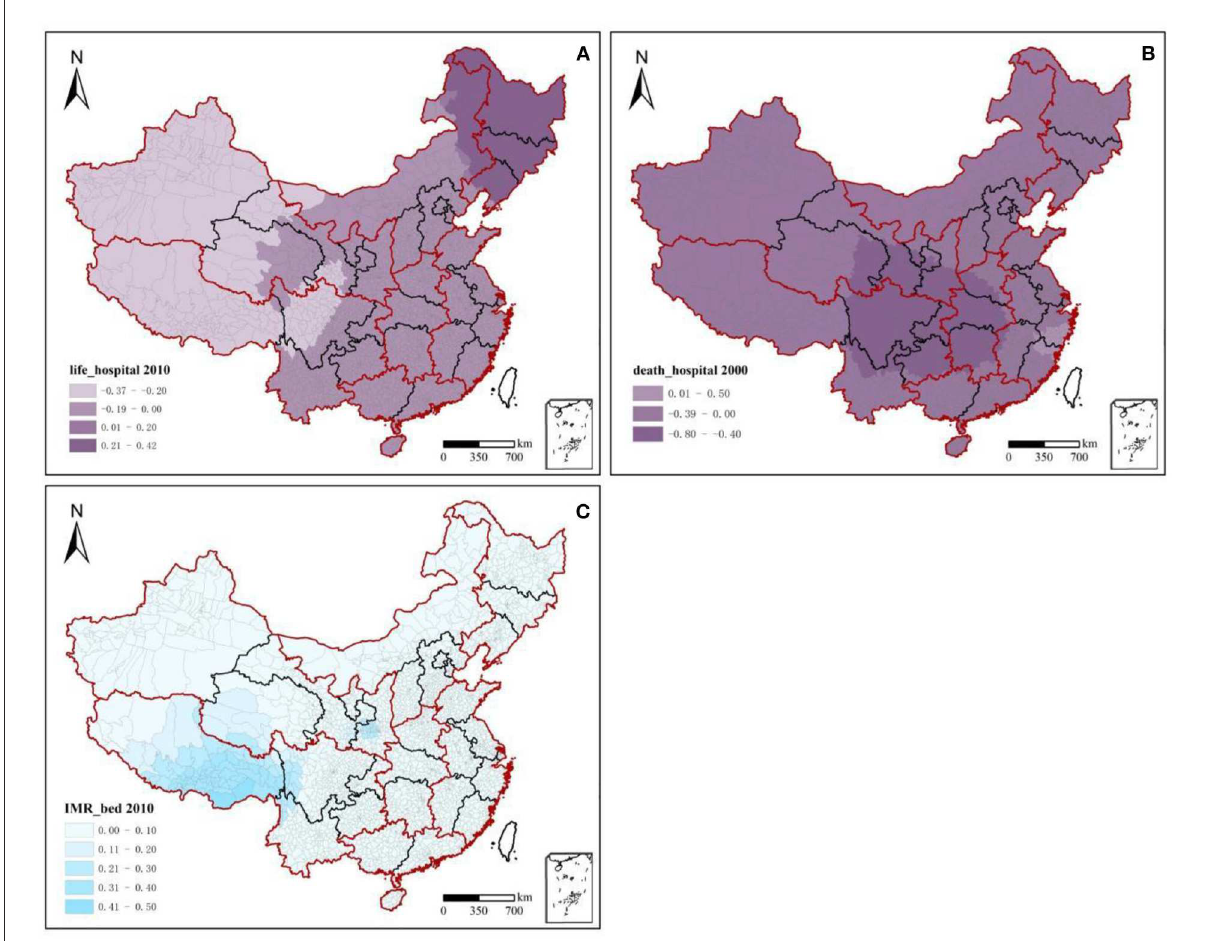
FIGURE6 Spatial patterns of health facilities and hospital beds influencing population health,